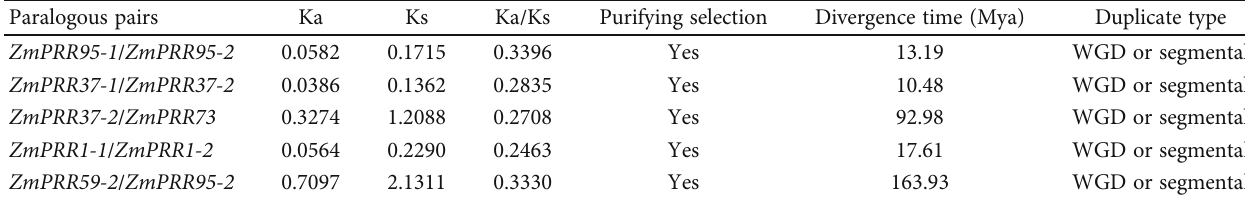
Table 2: Ka/Ks analysis and estimated divergence time for the duplicated ZmPRR